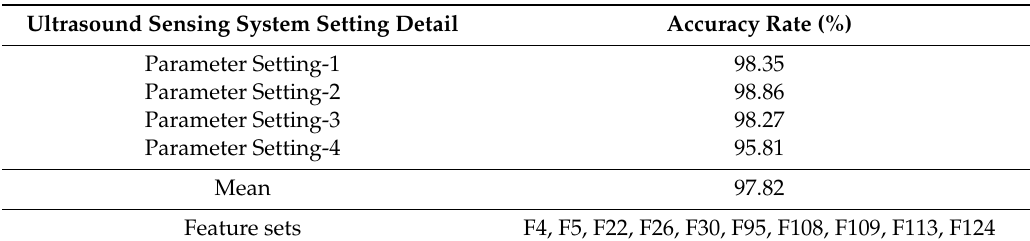
Table 13. Classification results of the SVM-enabled intelligent genetic algorithmic model when it chooses 10 universal features.